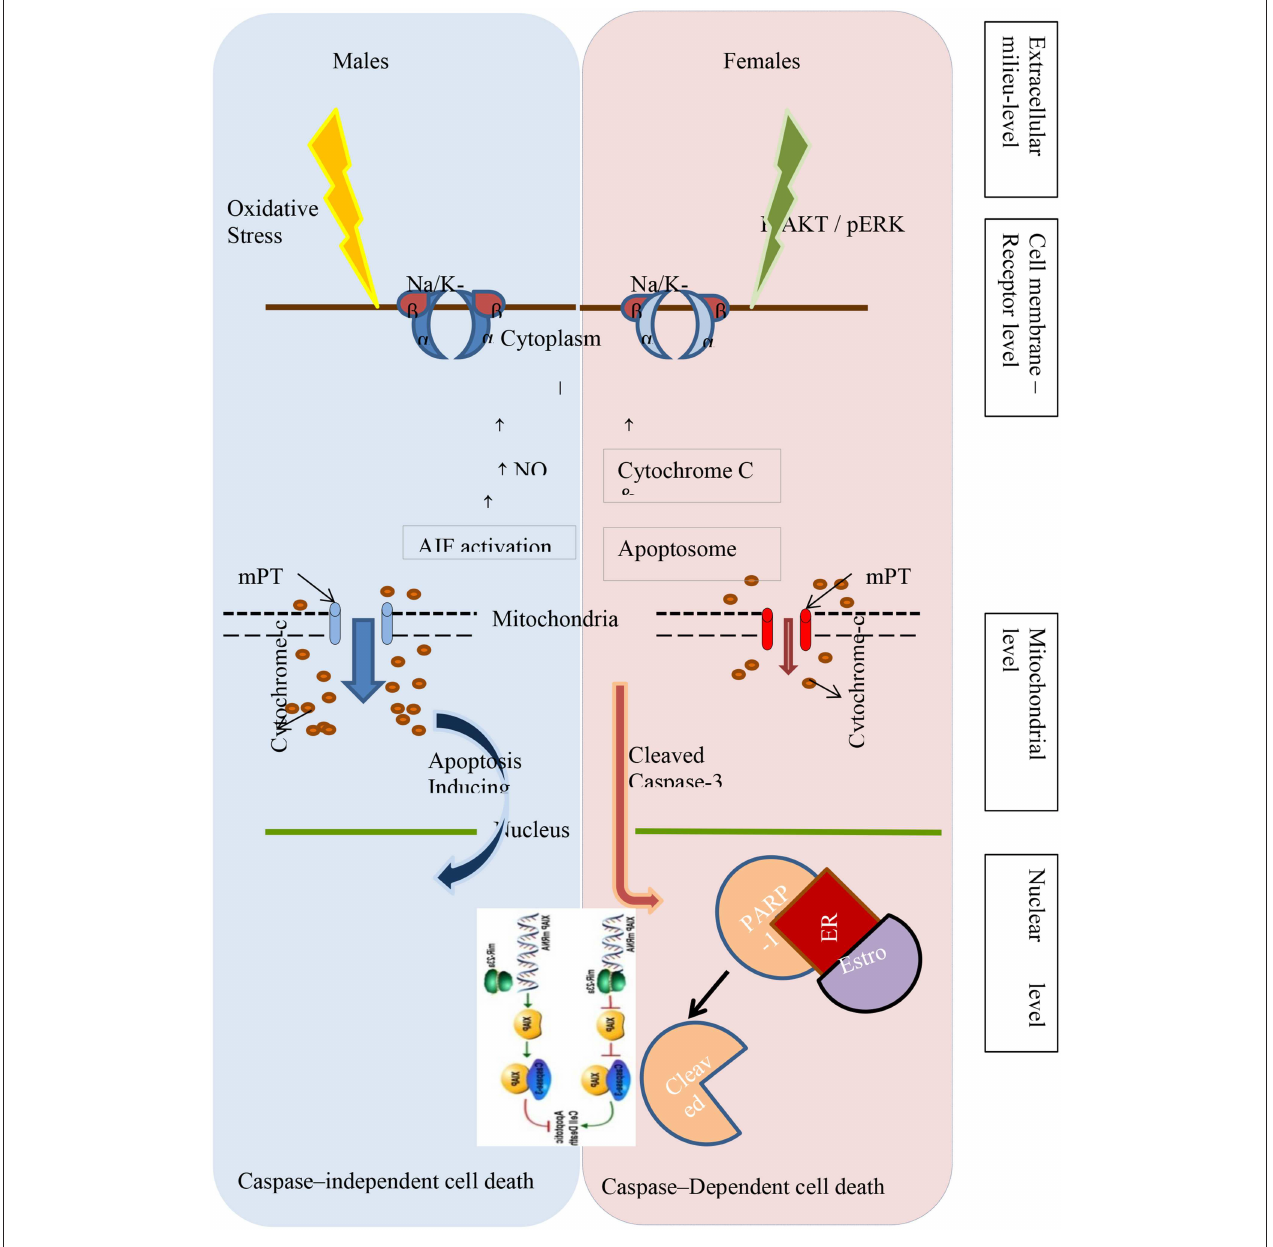
FIGURE 1 | Different pathways of programmed cell death in the male and female newborn brain following hypoxic-ischemic injury.